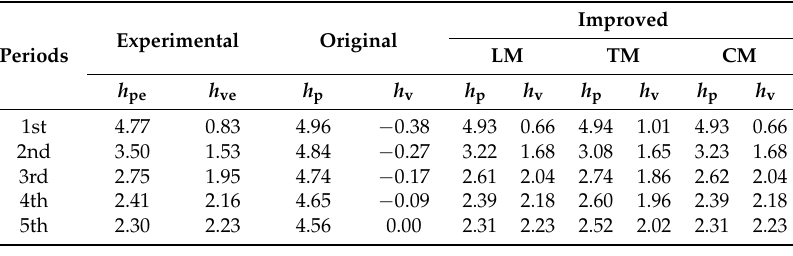
Figure 10. The analysis of the sum of squared residuals. Table 1. The attenuation of peak pressures from experiment and improved simulations.